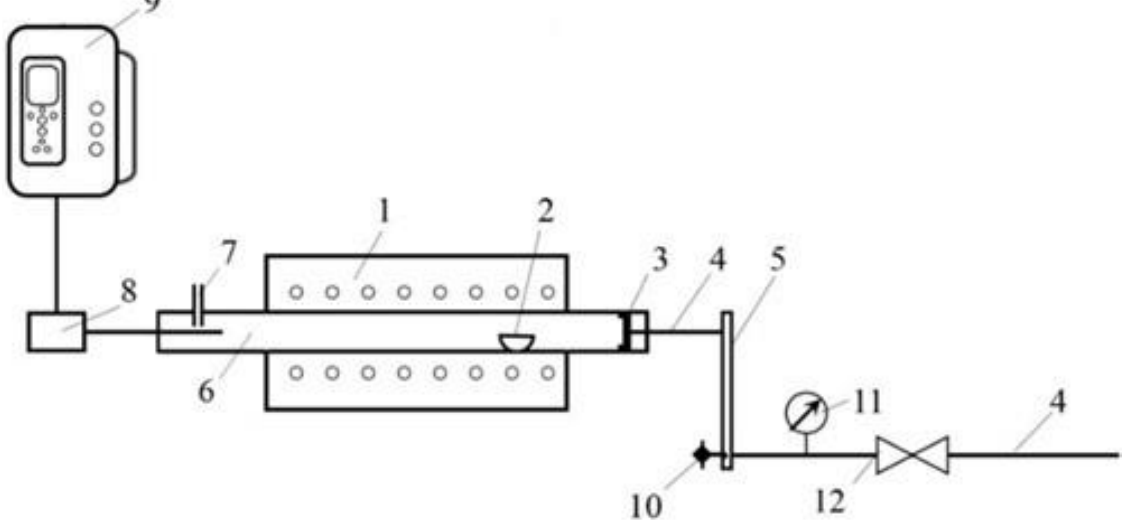
Figure 2. Schematic diagram of biomass thermal conversion and smoke emission test bench: 1, tubular heating furnace; 2, crucible with a sample of combusted biomass; 3, sealing plug; 4, air supply hose; 5, air flow meter; 6, combustion chamber; 7, chimney; 8, smoke extractor; 9, smoke analyzer; 10, air flow control valve; 11, manometer; 12, valve.